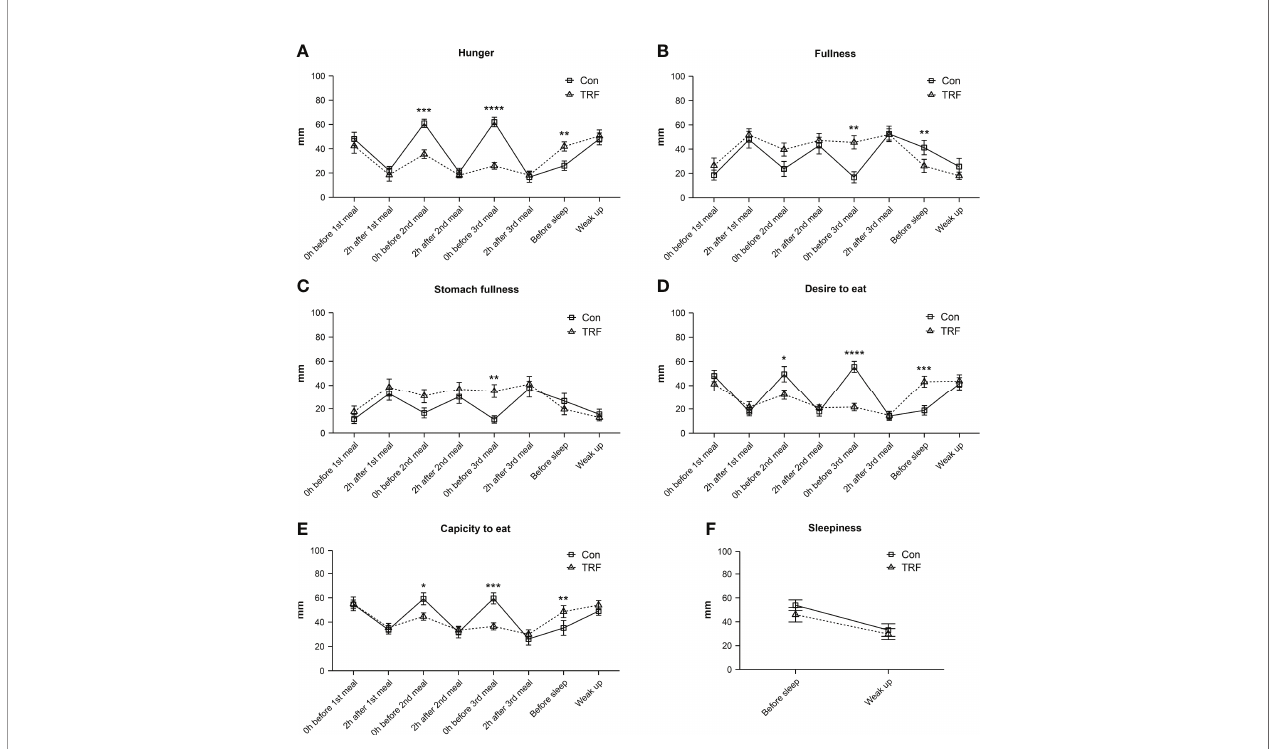
FIGURE 7 | Subjective hunger (A) , fullness (B) , stomach fullness (C) , desire to eat (D) , capacity to eat (E) , and sleepiness (F) responses to VAS from participants during TRF and control intervention. Data are mean ± SEM, *P <0.05, **P<0.01, ***P<0.001,****P ≤